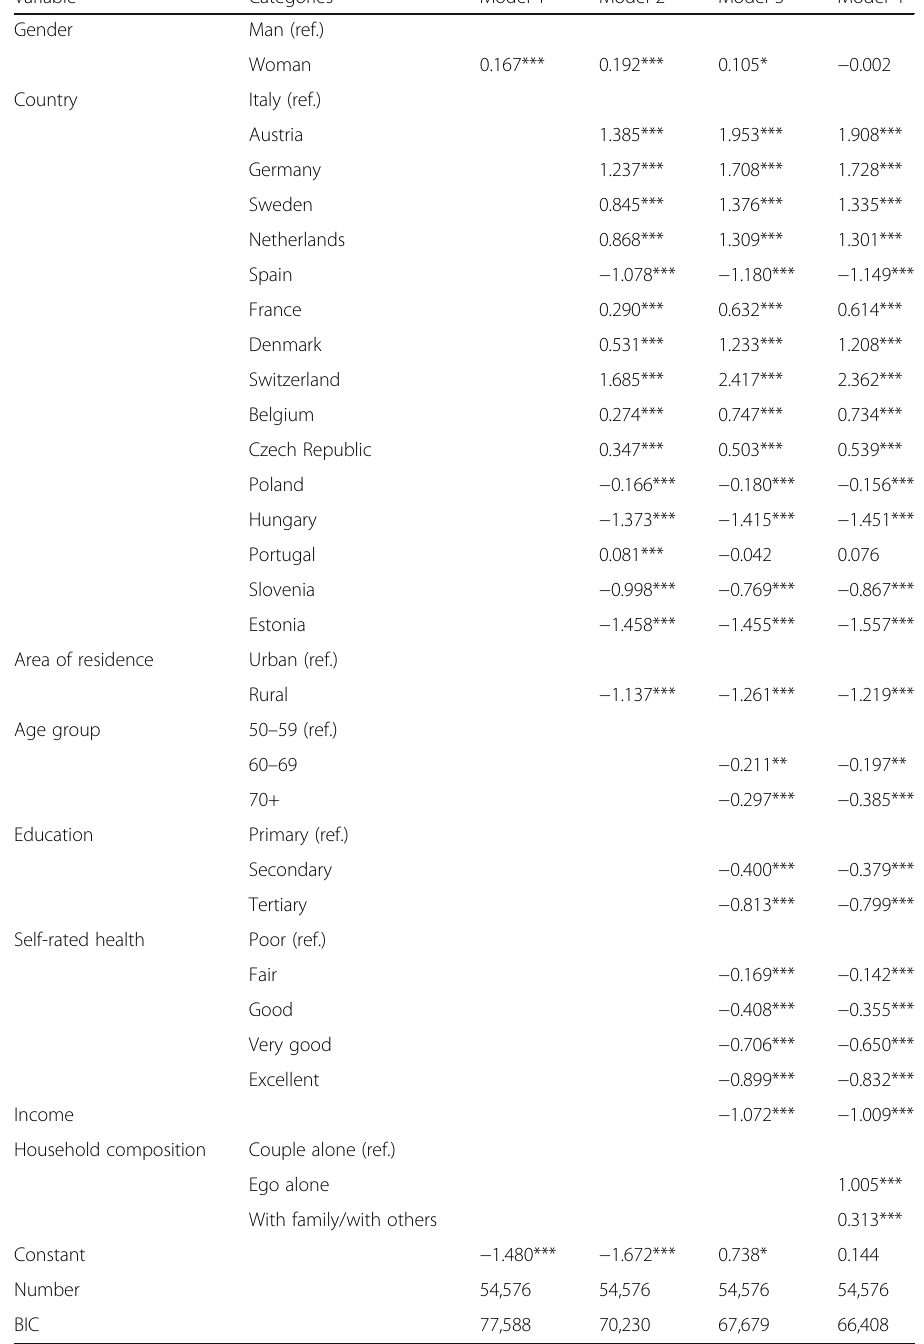
Table 1 Multinomial regression models predicting the exclusion from home ownership (tenants versus